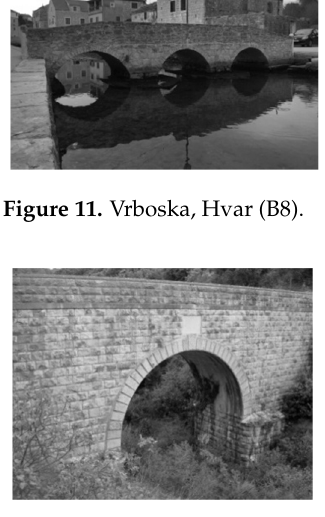
Figure 12. Franjo Josip, Bra č (B9).